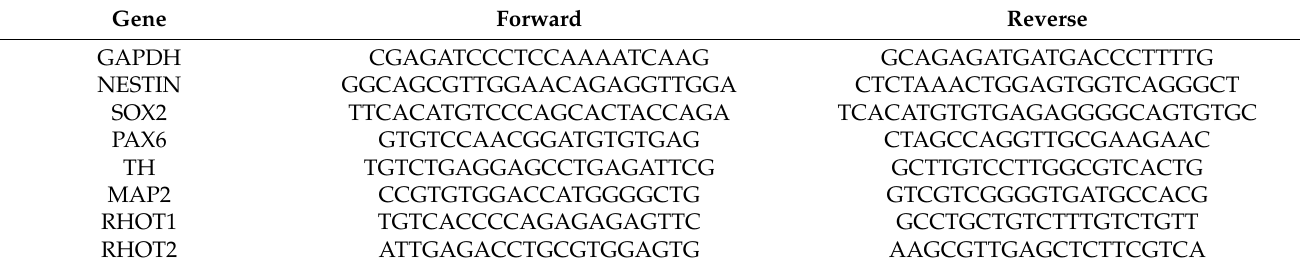
Table 1. Primers used for